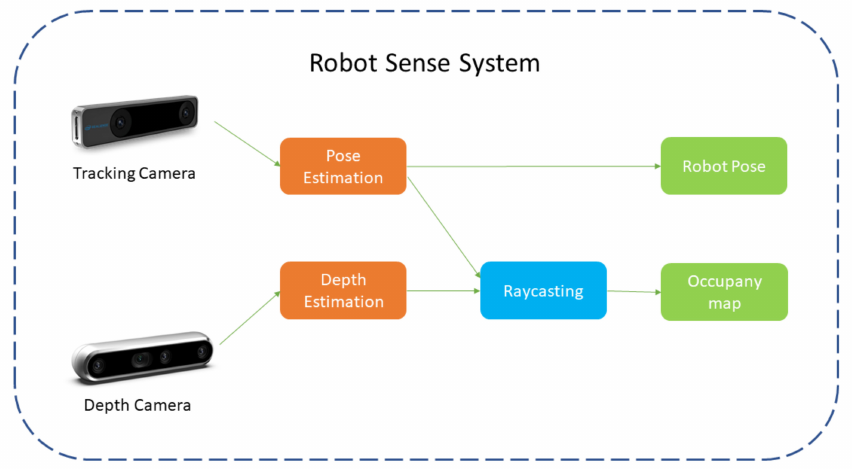
Figure 2. Schematic of the framework of the environmental perception system. The system uses a tracking camera and a depth camera as sensors to realize the estimation of the robot’s pose and build a map of the